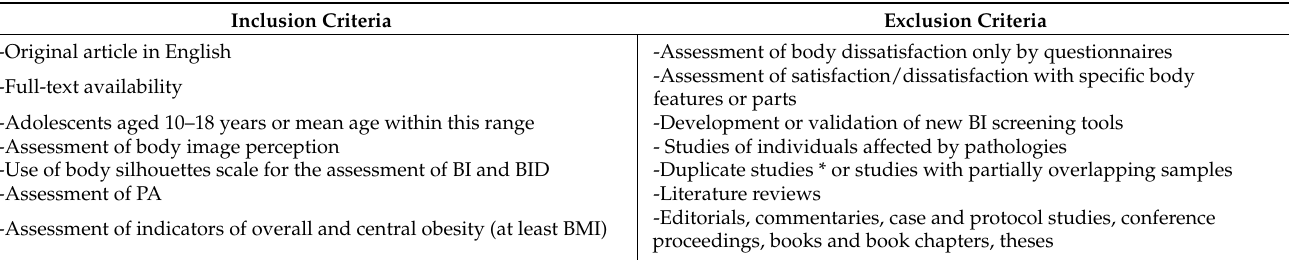
Table 1. Inclusion and exclusion criteria used in the articles